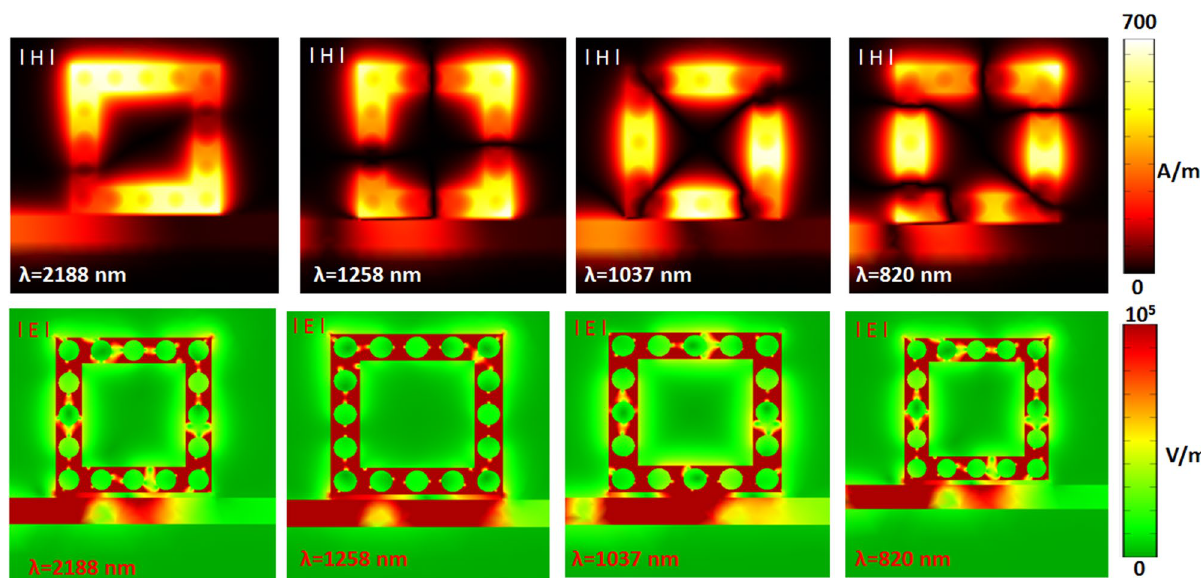
Figure 3. Truncate views of magnetic field (|H|) and electric field (|E|) patterns at the corresponding wavelengths from mode 1 to mode 4 in case 2 structure,